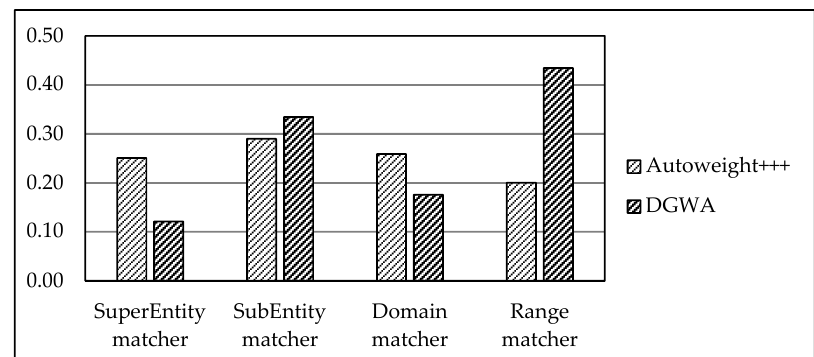
Figure 14. The average values of weighted factors assigned to the structure matchers by using aggregation methods Autoweight+++ and DGWA while matching the entire Benchmark biblio ontology track .